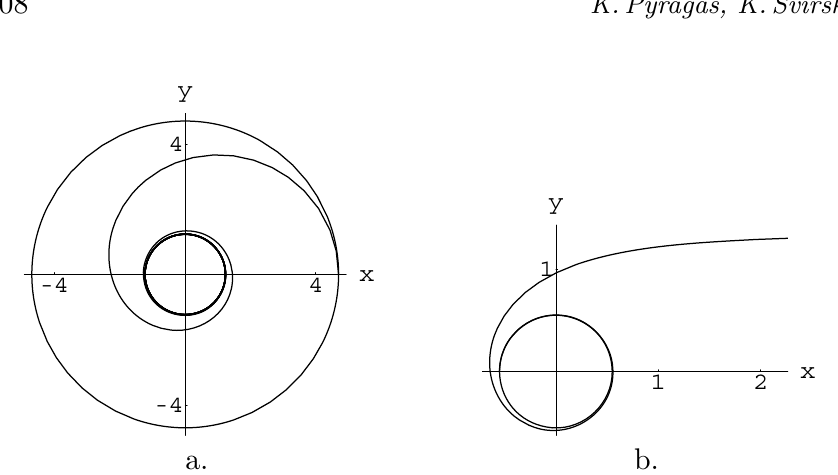
√ 3 , h = h 2 = 2 . 089 and (b)